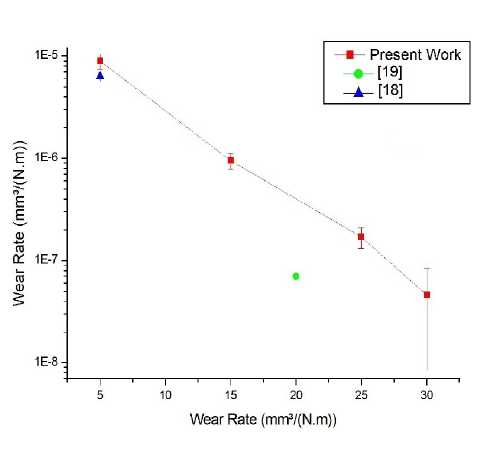
O -NbC compositions. 2 3